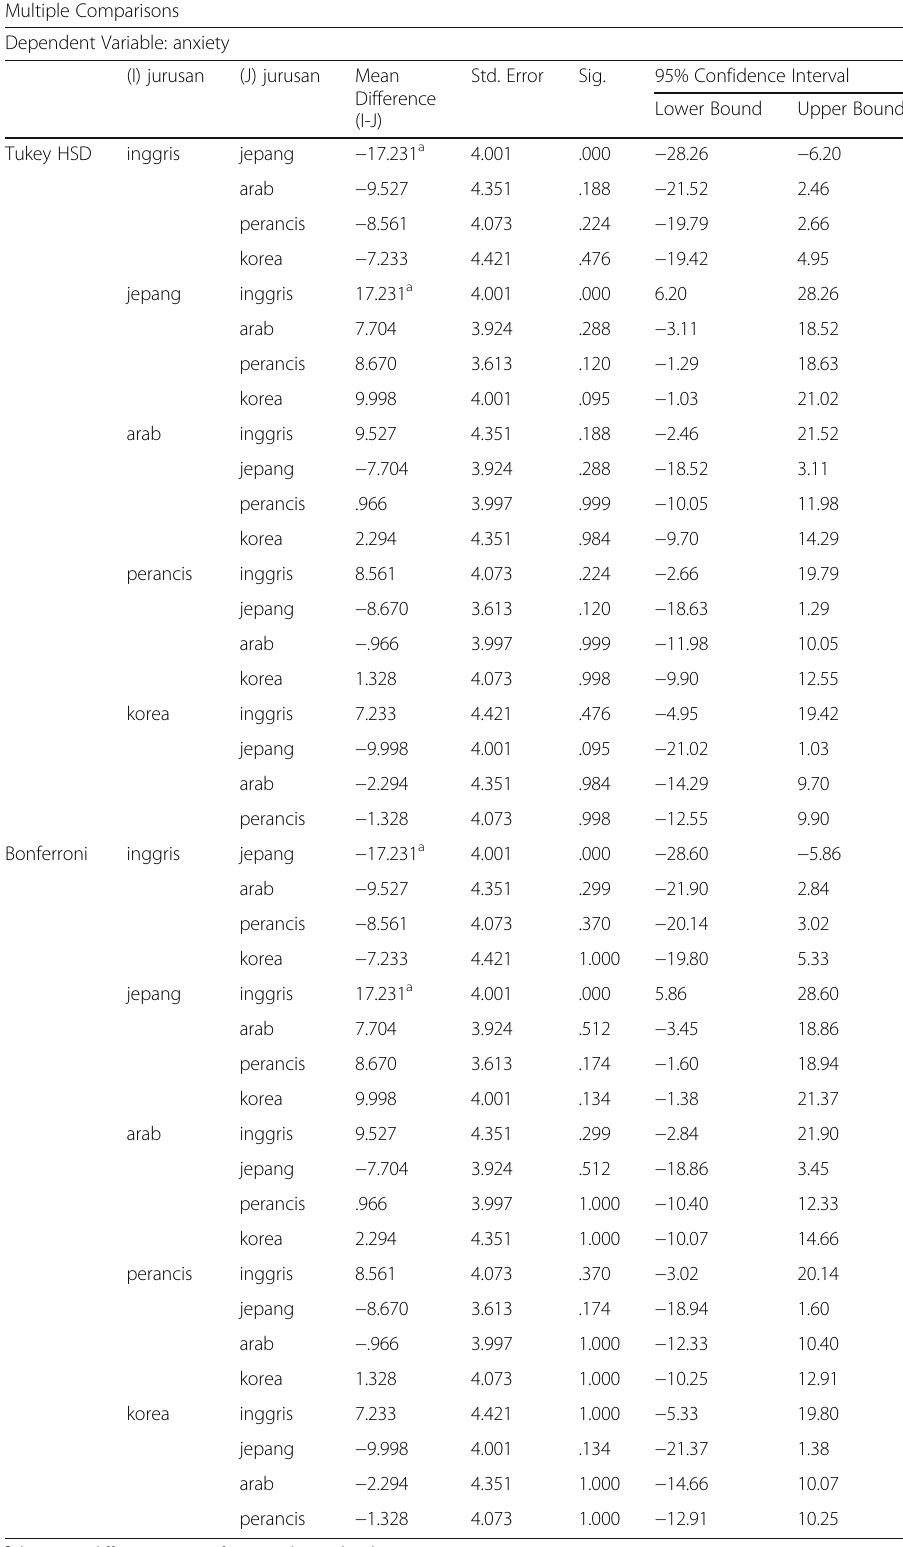
Table 3 Post-Hoc Test of Foreign Language Anxiety Scale Multiple